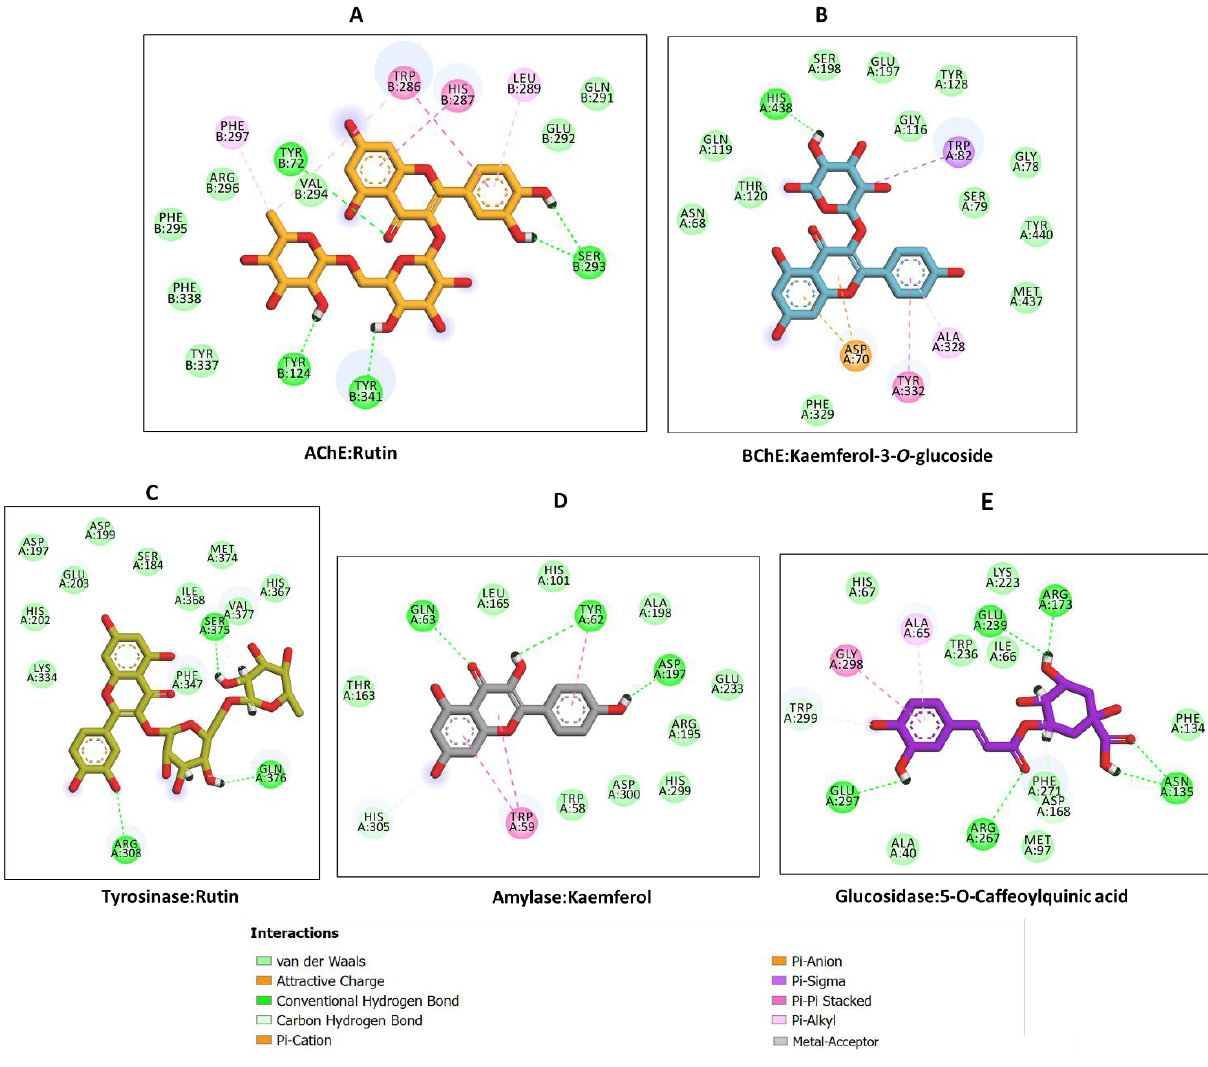
Figure 3. Protein–ligand interactions: ( A ) AChE and rutin, ( B ) BChE and kaempferol 3- O -glucoside, ( C ) tyrosinase and rutin, ( D ) amylase and kaempferol and ( E ) glucosidase and 5- O -caffeoylquinic acid.